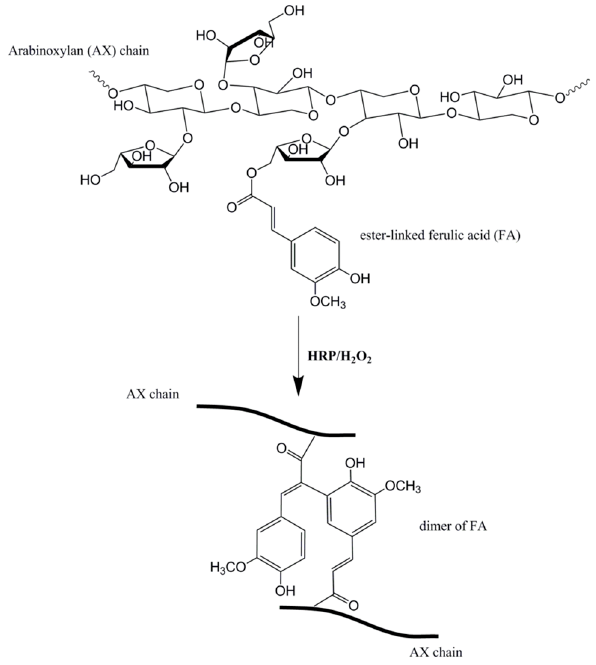
Figure 2. Arabinoxylan ferulate (AXF) structure composed of three components: xylose backbone substituted to arabinose sugar units, one of which is estyyanger-linked to ferulic acid. It can be crosslinked using HRP/H 2 O 2 . Figure adapted from reference [44] with permission.